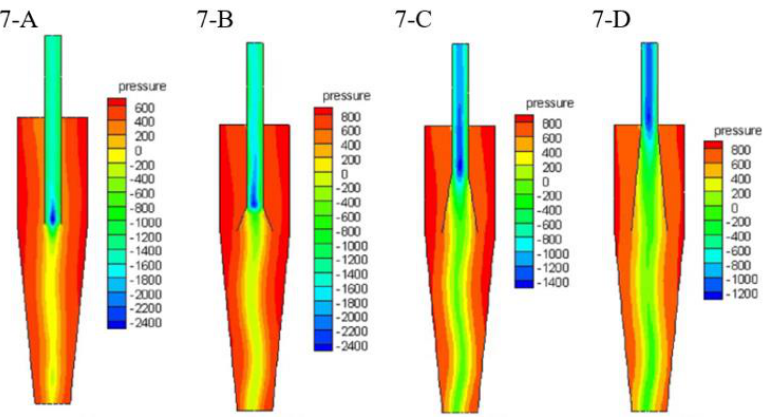
Figure 14. Pressure contours (Pa) at a flow rate of 70/min in the cyclone. Figure made by author based on data from paper [81].